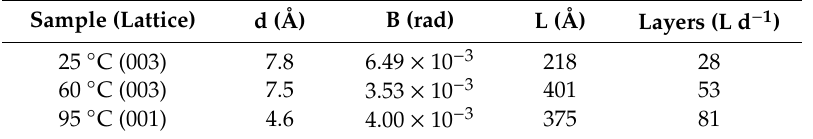
Table 1. Analysis data from XRD characterization.